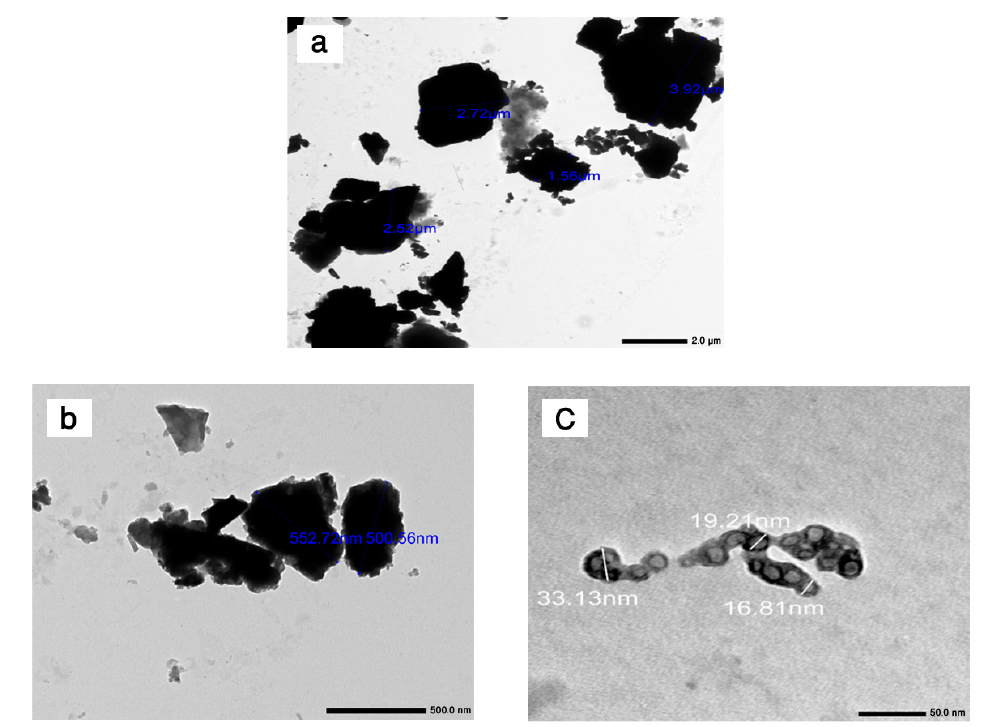
Figure 5. TEM images of ( a ) waste marble, ( b ) micro iron slag, and ( c ) nano iron slag powders.